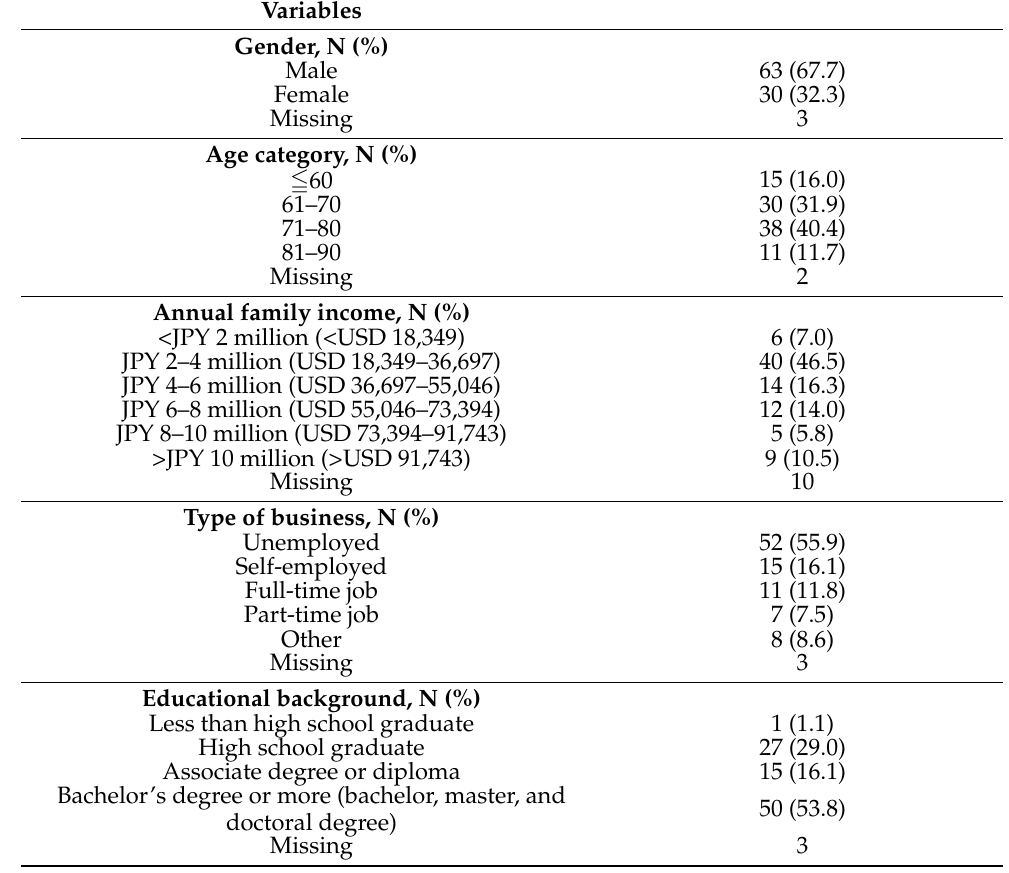
Table 1. Demographic features of the study